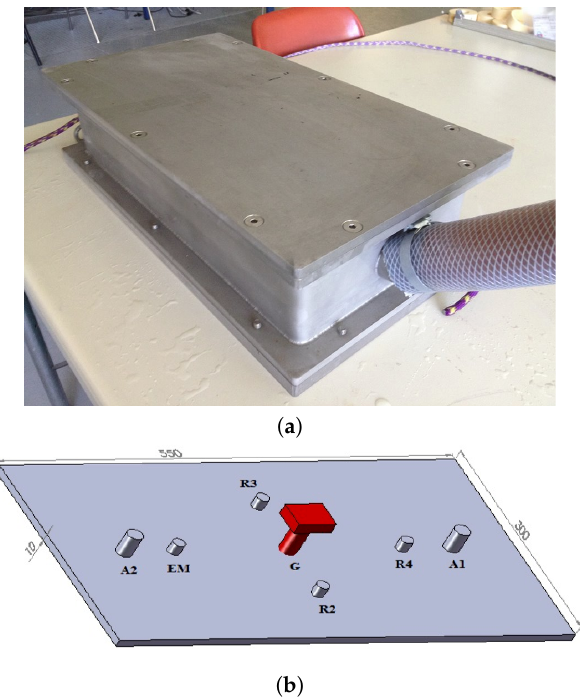
Figure 1. Multisensor bedload transport monitoring platform: ( a ) general view and ( b ) set-up of the acoustic sensors on the top steel plate (units expressed in